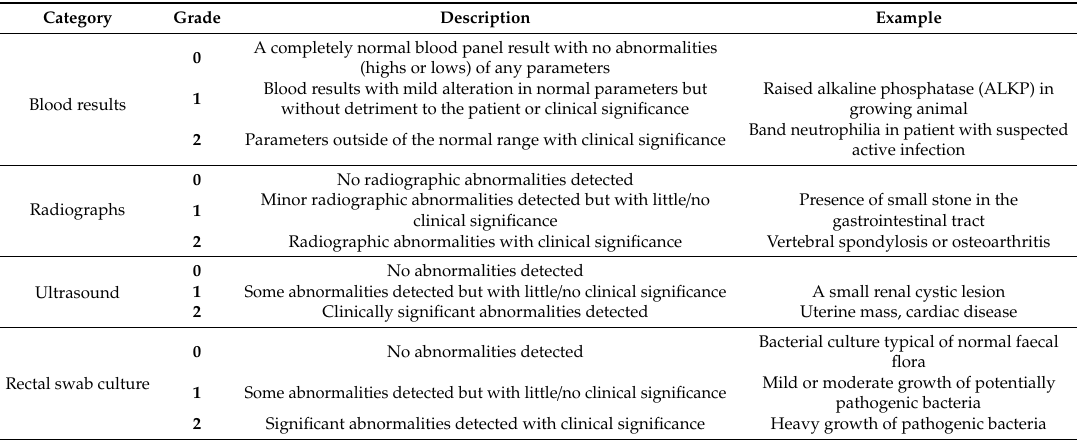
Table 3. Definitions and examples of categorising system used for grading the presence, absence and / or severity of abnormalities detected by diagnostic